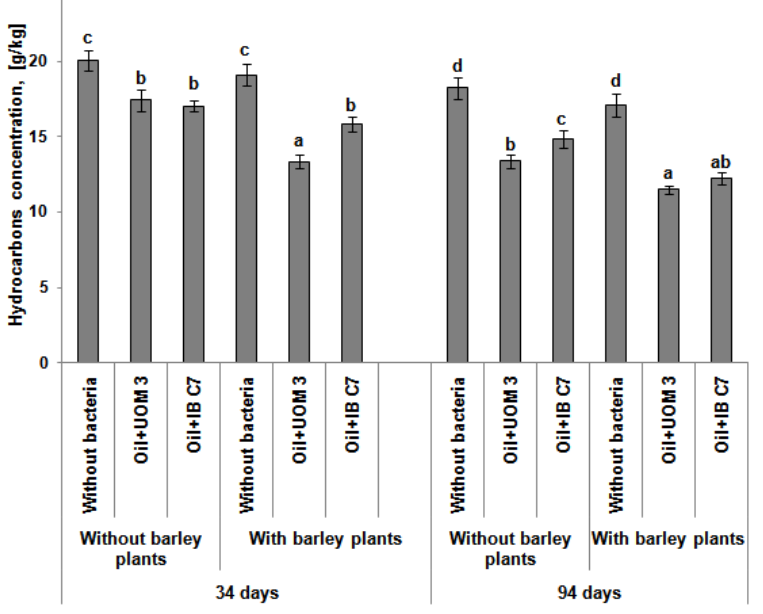
Figure 3. Hydrocarbon content in the soil 34 and 94 days after germination. UOM 3 and IB, variants of experiments with introduction of Enterobacter sp. UOM 3 and P. hunanensis IB C7, respectively. Statistically different means values for each indicator are marked with different letters ( p ≤ 0.05) . Table 3. The number of microorganisms in the oil-contaminated soil, CFU/g.